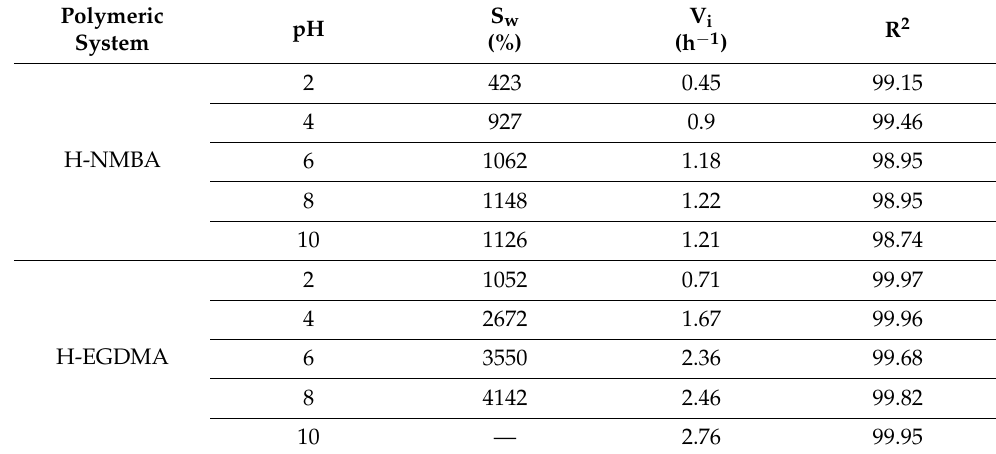
Table 2. Swelling percentages at 48 h and linear initial swelling velocity at different pHs a .